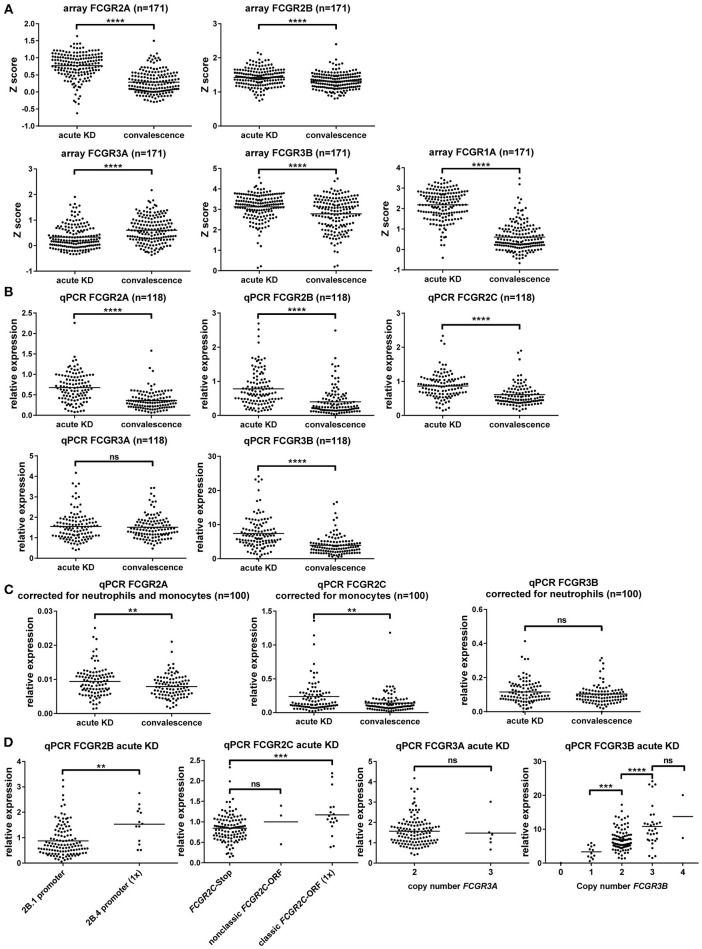
Gene expression analysis of FcγRs shows upregulation of FcγRI and FcγRII, but not FcγRIII during acute KD. (A) Difference in expression intensity of various FCGR transcripts, as determined by RNA microarray, shown as Z scores (higher score indicating higher expression), in 171 subjects with KD in the acute and convalescent phase of the disease. (B–D) Relative expression of different FCGR transcripts detected by qPCR on whole blood, corrected for housekeeping genes GUS and GAPDH, as compared to one randomly chosen sample in the convalescence phase of KD. (B) Dot plots showing a comparison of the acute and convalescent phase of KD in 118 patients. (C) Dot plots showing a comparison of the acute and convalescent phase of KD for transcripts of FCGR2A, FCGR2C, and FCGR3B in 100 patients for which WBC differentials were known, after correction for the main cell type that expresses the transcript. (D) Comparison of genotypes for the expression of various transcripts in 135 patients with acute KD. FCGR2B: patients with only the 2B.1 promoter (n = 122) or with 1 copy of the 2B.4 promoter (n = 13) in FCGR2B. FCGR2C: patients with the FCGR2C-Stop haplotype (n = 114), patients with 1 copy of the classic FCGR2C-ORF haplotype (n = 18), patients with 1 or 2 copies of the nonclassic FCGR2C-ORF haplotype (n = 3). FCGR3A patients with 2 copies (n = 129), or 3 copies (n = 6) of the FCGR3A gene. FCGR3B: patients with 0 copies (n = 1), 1 copy (n = 12), 2 copies (n = 89), 3 copies (n = 31) or 4 copies (n = 2) of the FCGR3B gene. ns: non-significant; **p < 0.01; ***p < 0.001; ****p < 0.0001 as determined by paired t-test or Wilcoxon matched-pairs signed rank test (A–C) or students t-test or Mann Whitney test (D).